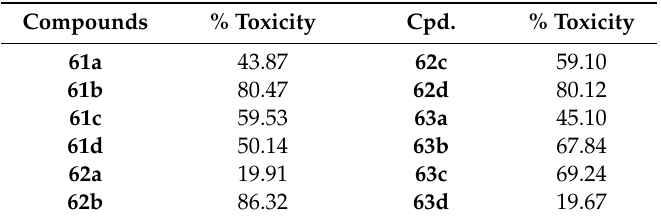
Table 9. % toxicity of the compounds on Leishmania intracellular amastigotes after 48 h. All compounds were 10 µ M [3]. Compounds % Toxicity Cpd. %